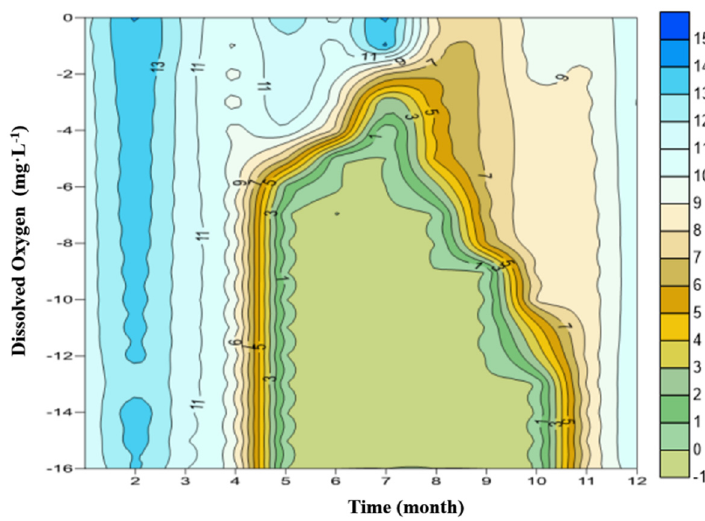
Figure 4. Profile of dissolved oxygen of ZCR.